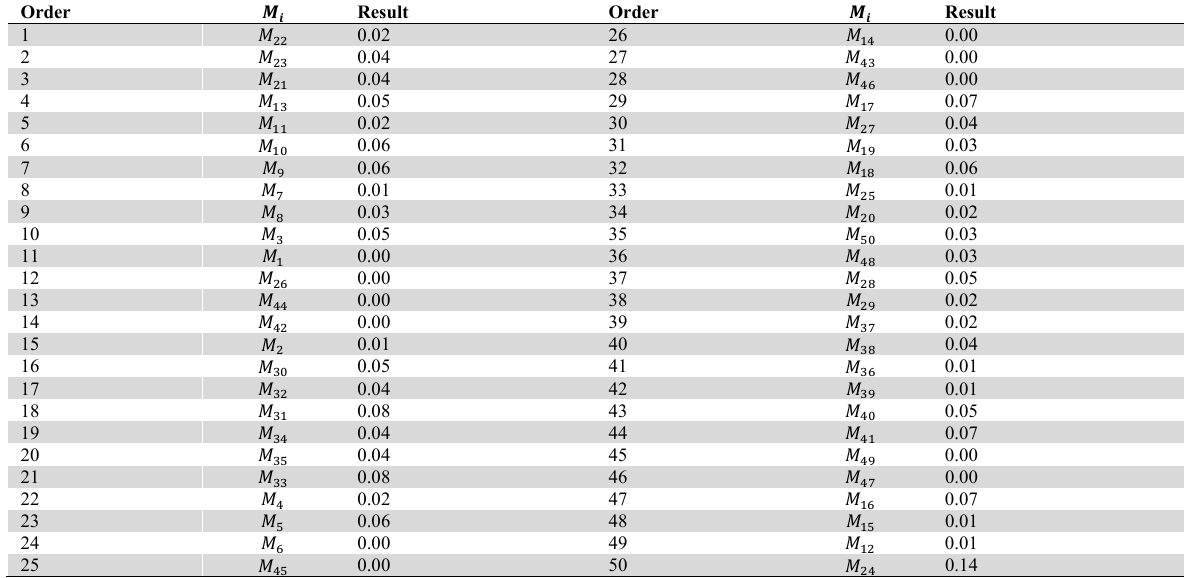
Results of the Best Machine Ranking